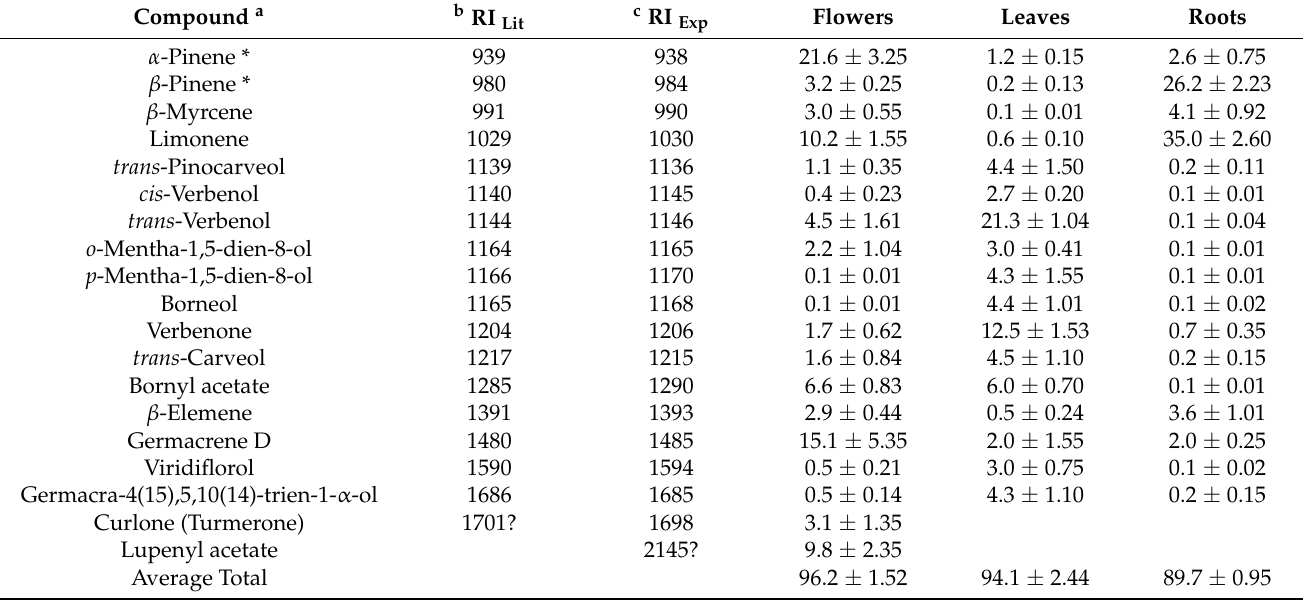
Table 5. Main chemical composition ( ≥ 3.0%) of Solidago canadensis inflorescence, leaf and